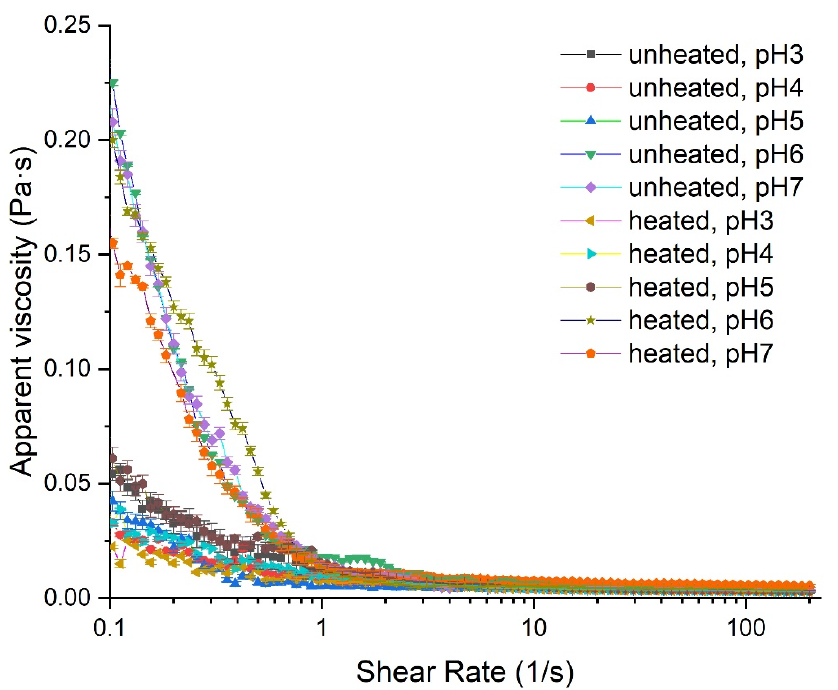
Figure 6. Effect of pH and heat treatment on the apparent viscosity of emulsions stabilized by PA/DS soluble complexes.